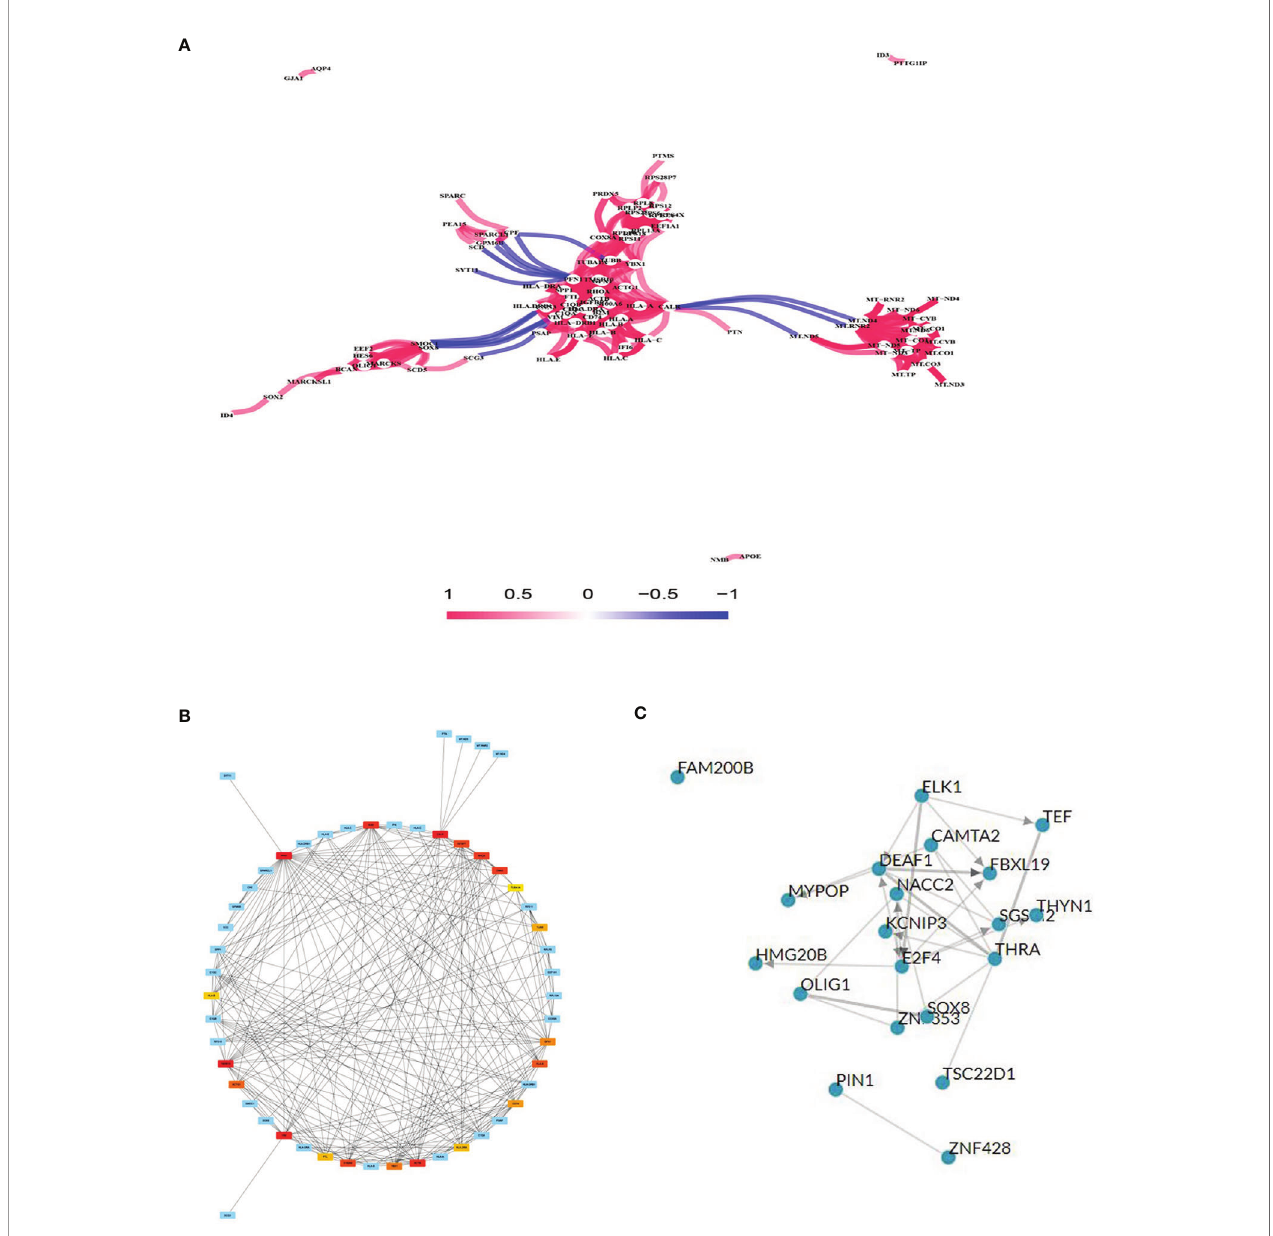
FIGURE 3 | Gene co-expression network analysis and transcription factor (TF) prediction. (A) Gene co-expression network analysis with differentially expressed mRNAs. (B) Network of top 20 hub genes in the gene co-expression network. (C) TF prediction of differentially expressed